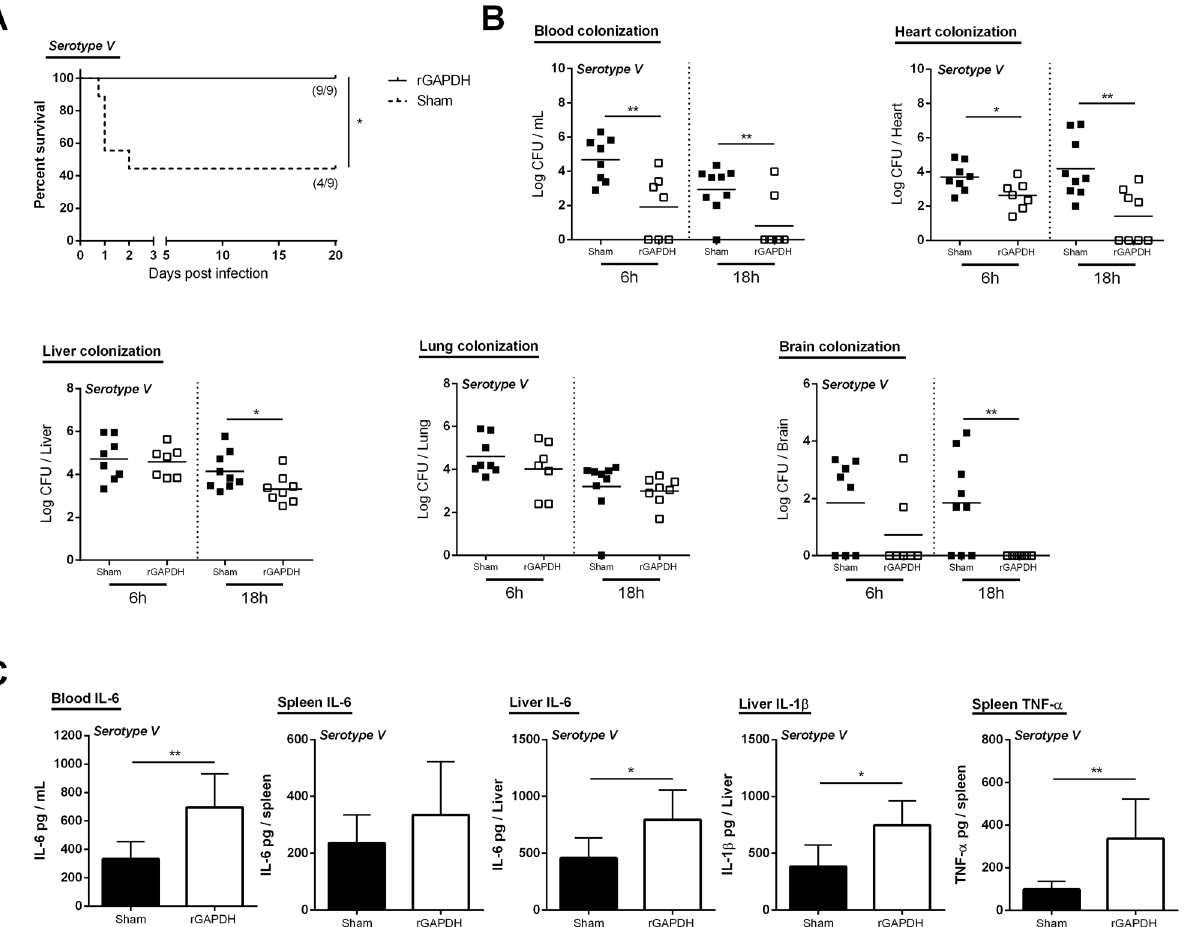
Fig 4. rGAPDH vaccination improves survival and induces protection against serotype V GBS infection in an adult mouse model. A) Kaplan – Meier survival curves. The lethality was monitored for 20 days. The numbers in parentheses represent the number of animals that survived out of the total number of infected animals. B) Blood. liver. lung. heart and brain colonization 6 and 18 hours post-infection and (6 hours — Sham n = 8. GAPDH-immunized n = 7; 18 hours — Sham n = 9. rGAPDH-immunized n = 8) C) sera. liver and spleen cytokine production 3 hours post-infection (n = 6 for both groups). Balb/c mice were immunized three times, with a three week interval, with 20 μ g of rGAPDH in 1:40 Alhydrogel or treated with Alhydrogel alone and infected i.p. with 3x10 7 CFU of 2603V/R (serotype V). Unpaired Student ’ s t-test. * p < 0.05; ** p < 0.01; *** p <